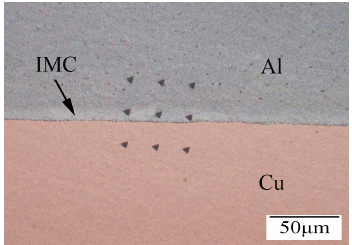
Figure 8. Nanoindentation test on the interface of the joint welded with the 240 ms duration under the static pressure of 7.2